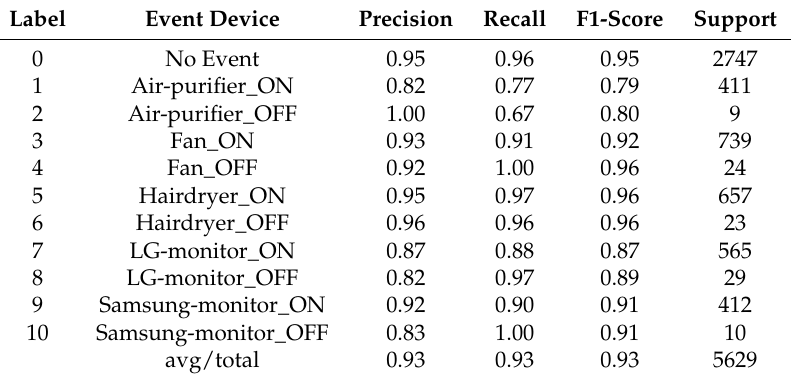
Table 7. Classification result for event detection ON/OFF of each appliance.